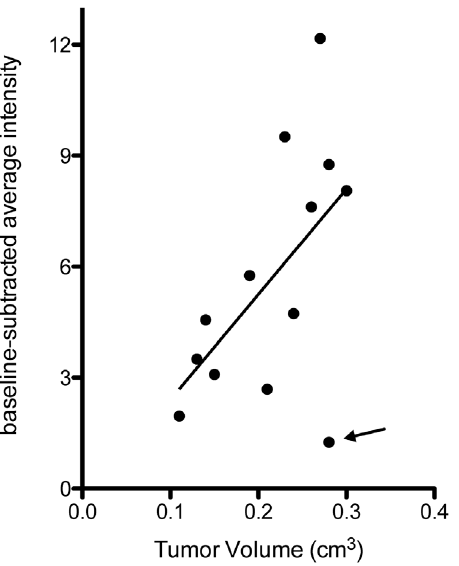
Figure 5. Video intensity from SFRP2 -targeted microbubble contrast agent correlated significantly with SVR angiosarcoma tumor volume. The baseline-subtracted average pixel intensity for each tumor was plotted against tumor volumes determined using our three-dimensional B-mode scans. Only 1 of 13 animals was observed to have higher signal for the streptavidin control than for the SFRP2 - targeted microbubbles (indicated by arrow). Correlation analysis showed a significant positive relationship between SFRP2 video signal and tumor volume as both increased together whether analyzed with (p=0.048, Pearson r=0.56) or without (p=0.003, Pearson r=0.78) the single ‘‘outlier’’ animal. Linear regression was used to determine the best-fit line through all data points to represent this